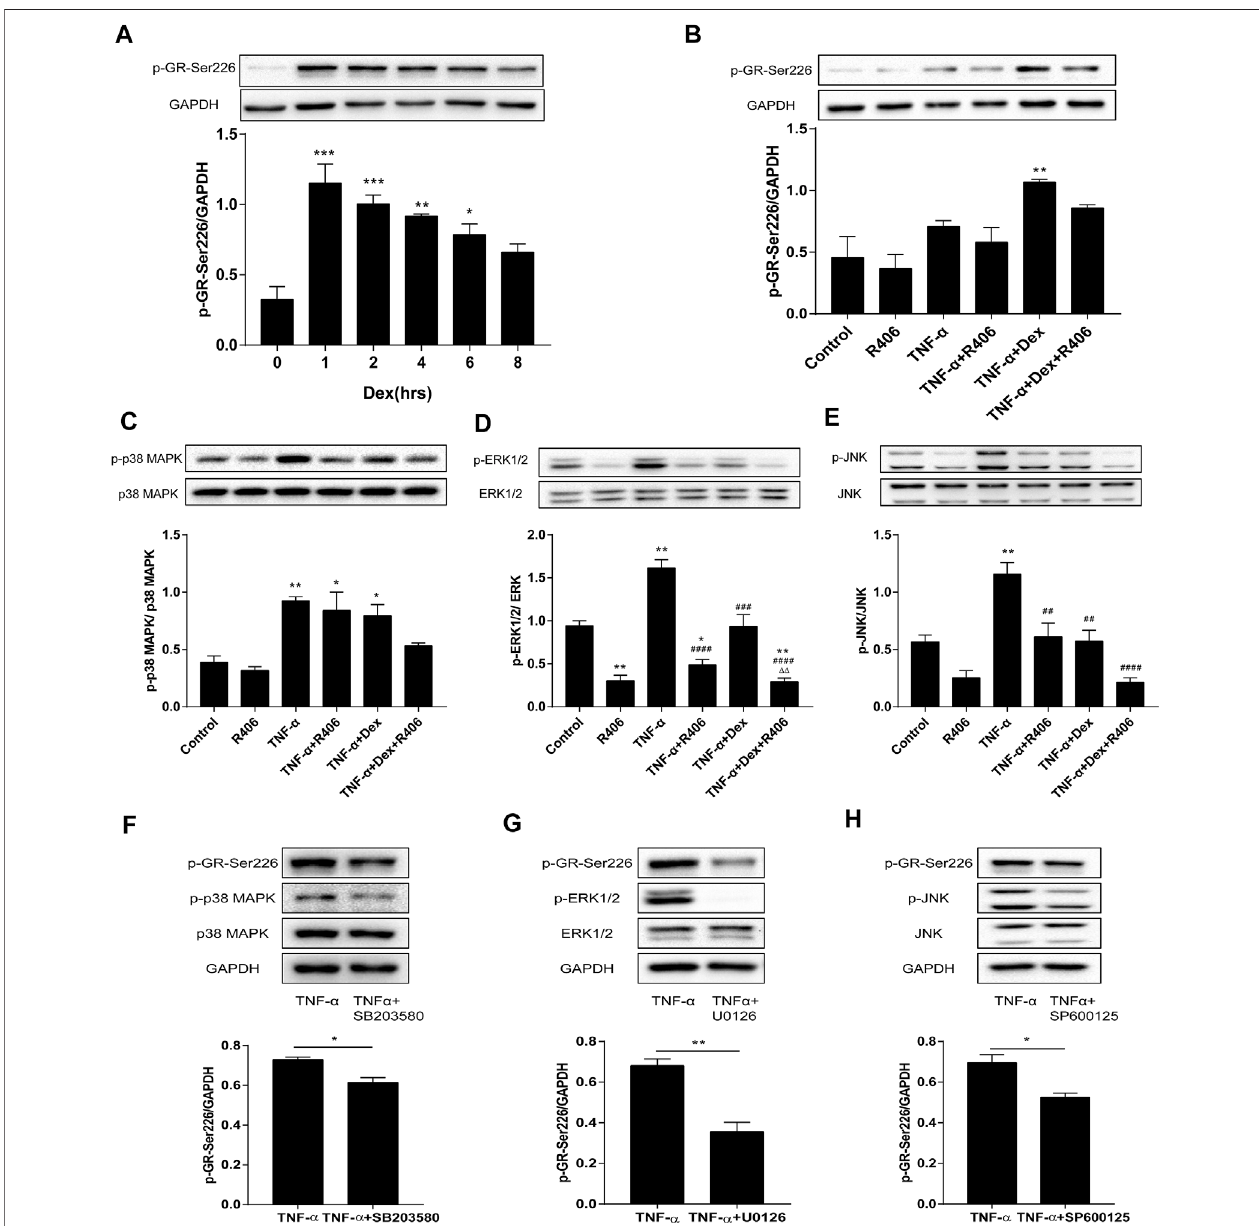
FIGURE4| TheSykinhibitorR406impairs thephosphorylationofGR-Ser226byinhibitingMAPKactivation. (A) BEAS-2B cellsweretreatedwithDex(1 μ M) for1, 2,4,6,and8 h,andthephosphorylatedproteinlevelsofGR-Ser226weremeasuredbyWesternblotting. n =3/group,* p < 0.05,** p < 0.01,*** p < 0.001. (B – E) BEAS- 2B cells were pretreated with R406 (1 M) for 30 min, incubated with Dex (1 μ M) for 2 h, and stimulated with TNF- α (10 ng/ml) for 1 h or 20 min. The phosphorylation levels of GR-Ser226 (B) , p38 MAPK (C) , ERK 1/2 (D) and JNK (E) were measured by Western blotting. n = 3/group, * p < 0.05, ** p < 0.01, compared with the control group; ## p < 0.01, #### p < 0.0001, compared with the TNF- α group; △△ p < 0.01, compared with the TNF- α +Dex group. (F – H) BEAS-2B cells were pretreated withap38MAPK inhibitor (SB203580,10 μ M),ERK1/2inhibitor (U0126,10 μ M) and JNKinhibitor (SP600125,5 μ M) for30 min and stimulated withTNF- α (10 ng/ml)